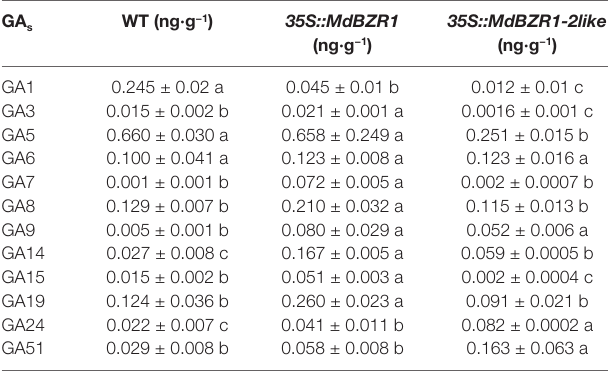
TABle 1 | GA levels in 35S::MdBZR1 and 35S::MdBZR1-2like apple